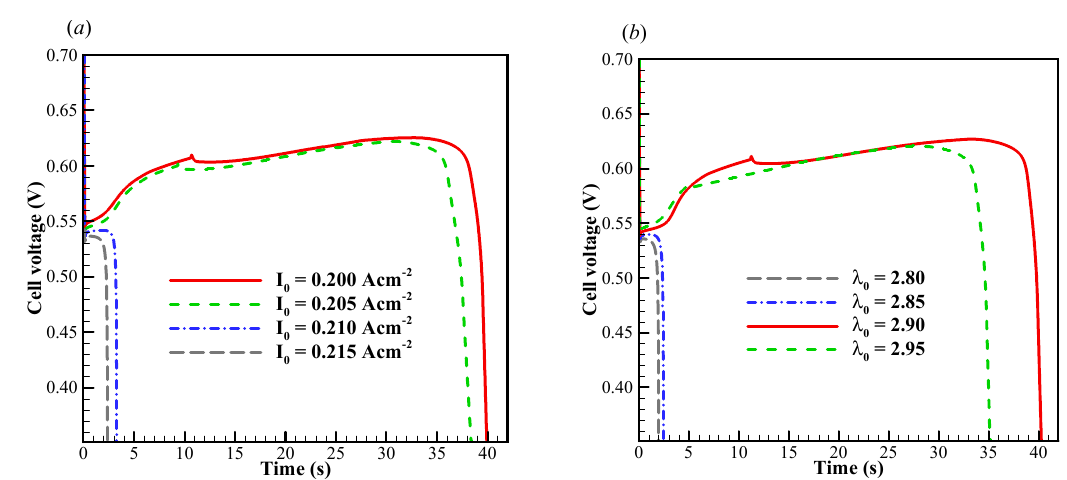
Figure 4. Evolution of cell voltage with various ( a ) startup current densities and ( b ) initial membrane water content. The cell is supplied with dry hydrogen and oxygen. The stoichiometry ratio of the mass flow rate is 2.0 for both anode and cathode sides. The cell starts from − 20 °C and the background pressure is 1.0 atm at both the anode and cathode outlets.